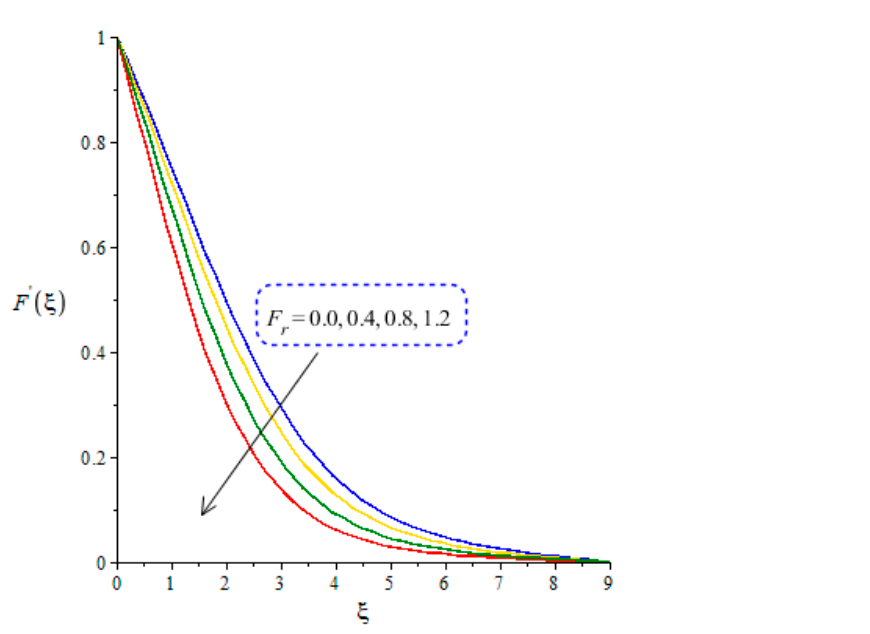
Figure 6. Variation role of F (cid:48) ( ξ ) versus F r when m = 0.3, We = 3, Ω = 2.0, M 2 = 0.33, β e = 0.2, Figure 6. Variation role of 𝐹′(𝜉) versus 𝐹 (cid:3045) when 𝑚 = 0.3, 𝑊𝑒 = 3, Ω = 2.0, 𝑀 (cid:2870) = 0.33,𝛽 (cid:3032) = β i = 0.01, (cid:101) = 0.01, Pr = 204, Ec = 0.34, ϕ 2 = 0.0075, ϕ 1 = 0.002, ϕ 3 = 0.005. 0.2, 𝛽 (cid:3036) = 0.01,𝜖 = 0.01, 𝑃𝑟 = 204, 𝐸𝑐 = 0.34,𝜑 (cid:2870) = 0.0075, 𝜑 (cid:2869) = 0.002,𝜑 (cid:2871) = 0.005.